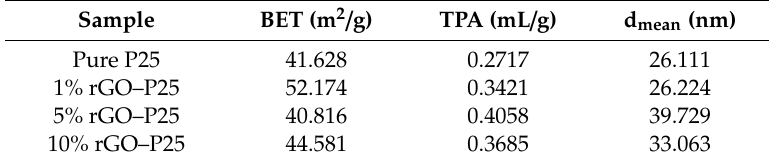
Table 1. The pore parameters and specific surface area of pure P25, 1%, 5%, and 10% rGO–P25.